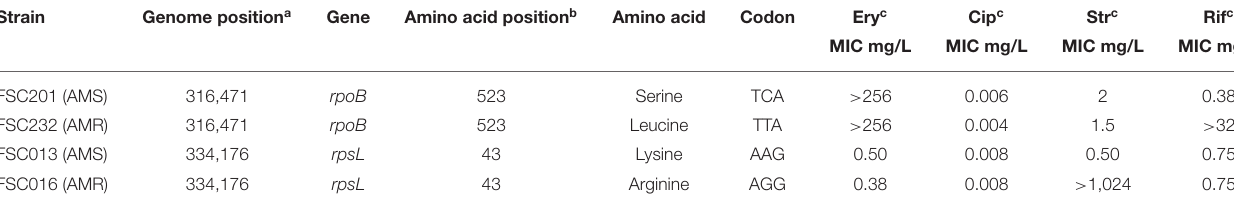
TABLE 1 | Genome mutations and antimicrobial resistance of F. tularensis strains. Strain